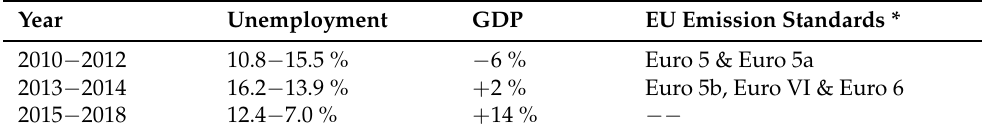
Table 2. Economic data and EU emission standards.